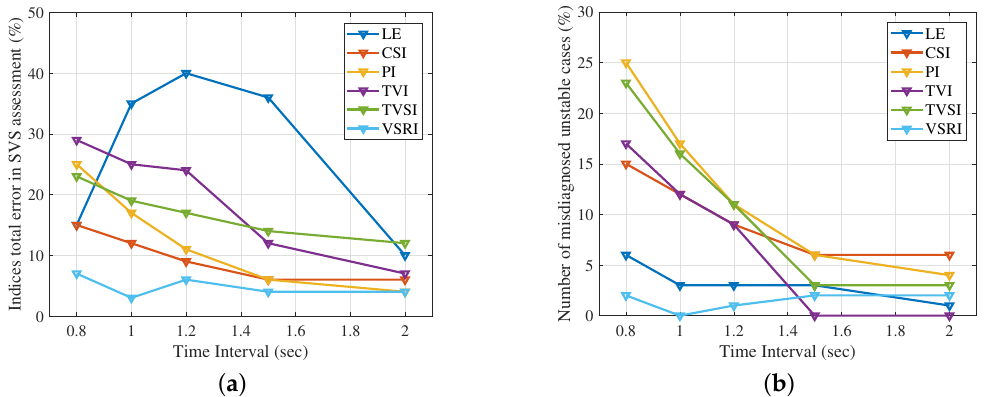
Figure 11. Linear approximation of index error in SVS